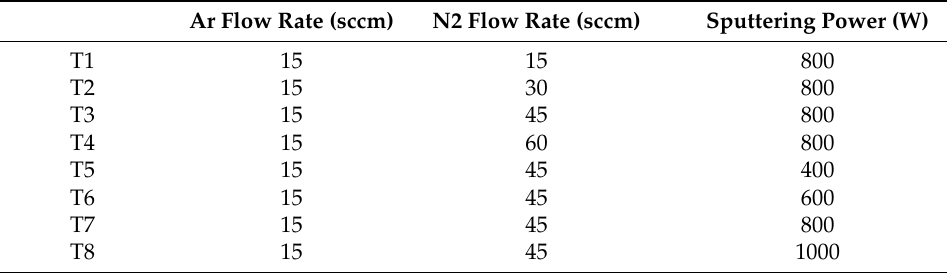
Table 1. Experimental parameters of experiment T1–T8.